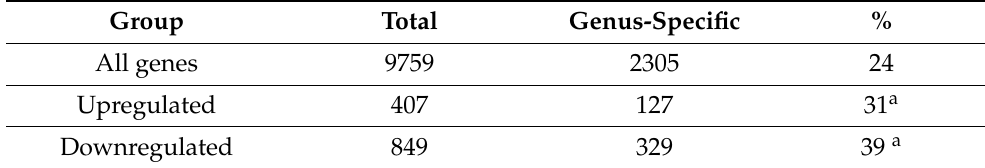
Legend Table 2: Comparison of the number of differentially expressed (young spherule/mycelia) genus-specific genes to all genus-specific genes. a) p value < 0.05 (Chi-square test) comparing the fraction of genus-specific genes in up- or downregulated genes to the fraction in all genes.